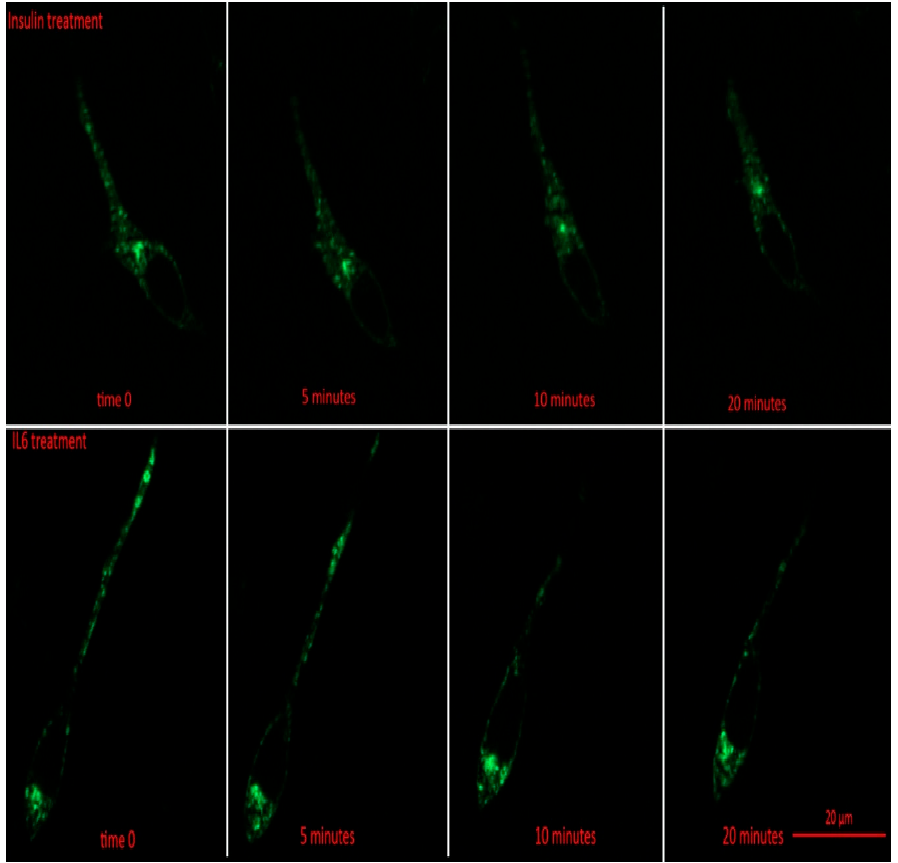
Figure 3. GLUT4-GFP Localization Following IL-6 and Insulin Treatment in Differentiated SH-SY5Y Cells. SH-SY5Y cells were treated with 100 nM of insulin, and 20 ng/mL of IL-6 for 5, 10, 15, 20, and 30 min. Fluorescent images of GLUT4-GFP in SH-SY5Y prior to and 5, 10, and 20 min post treatment with either IL-6 (bottom) or insulin (top).